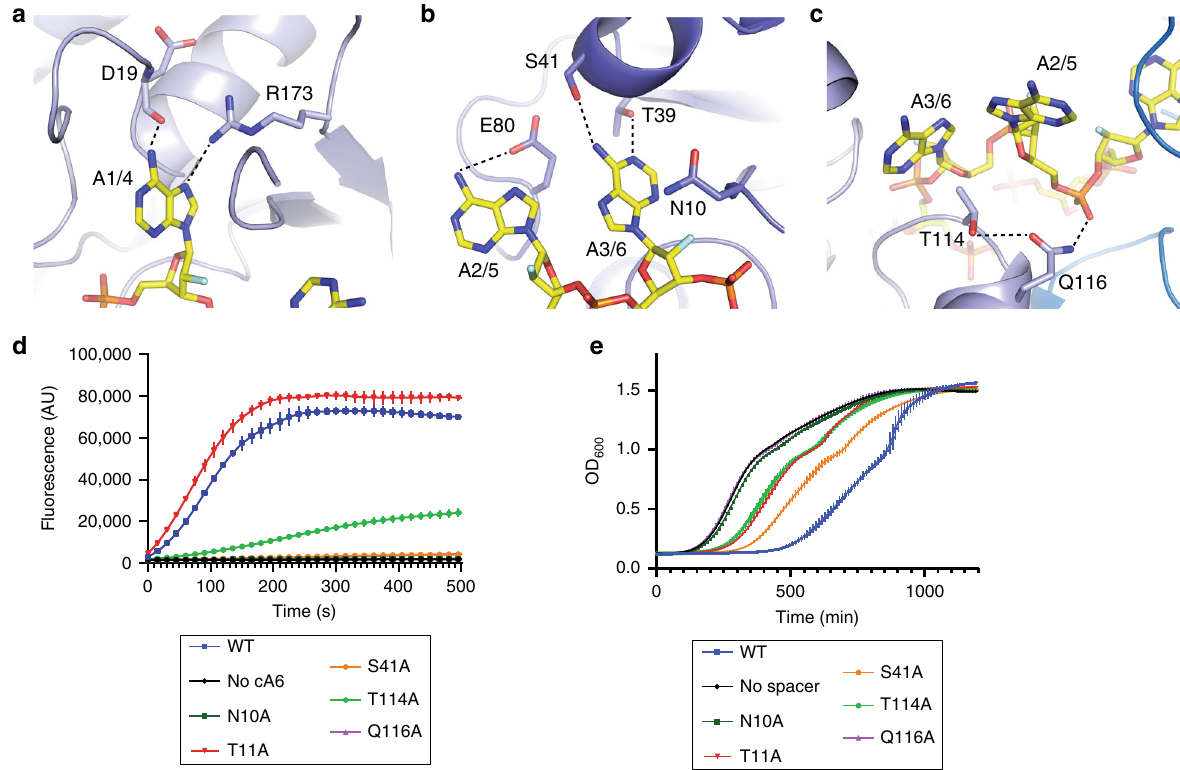
Fig. 2 The CARF domain of EiCsm6 recognizes cA6. a – c Protein-cFA6 interactions. EiCsm6 is depicted in cartoon representation; cFA6 is shown as sticks. Hydrogen-bonding interactions are represented as black dotted lines. d Fluorogenic RNase activity assay of CARF domain mutants of EiCsm6 (0.5 nM) in the presence of 10 nM cyclic-hexa-AMP (cA6). AU, arbitrary units. e Growth curves (optical density at a wavelength of 600 nm) of Staphylococcus aureus strains harboring pTarget and pCRISPR plasmids. The pCRISPR plasmid expresses wild-type or CARF domain mutants of EiCsm6 and the Staphylococcus epidermidis Cas10 – Csm effector complex containing an inactivating point mutation in the HD domain of Cas10. Data points in d , e represent the mean of three replicates; error bars represent the standard error of the mean (s.e.m.). Source data are provided as a Source Data fi